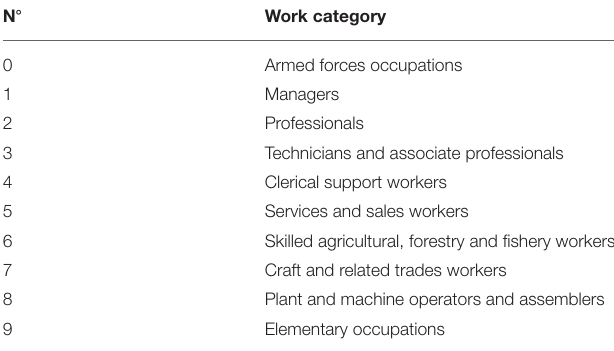
TABLE 1 | The international standard classification of occupations